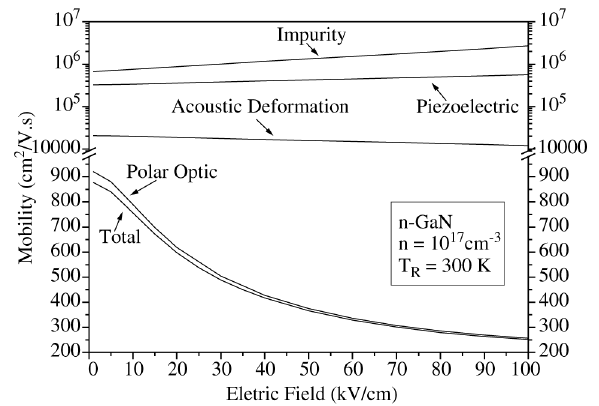
Figure 1. Electric field dependence of the electron mobility in wurtzite n-InN (solid line), n-GaN (dashed line), and n-AlN (doted). The lattice temperature is T = 300 K and n = 10 17 cm -3 0